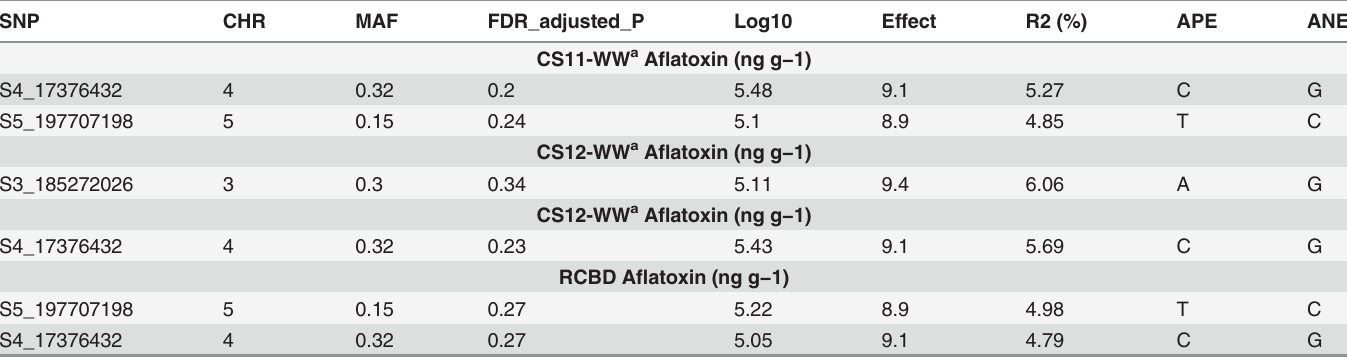
Table 12. GWAS results for a fl atoxin